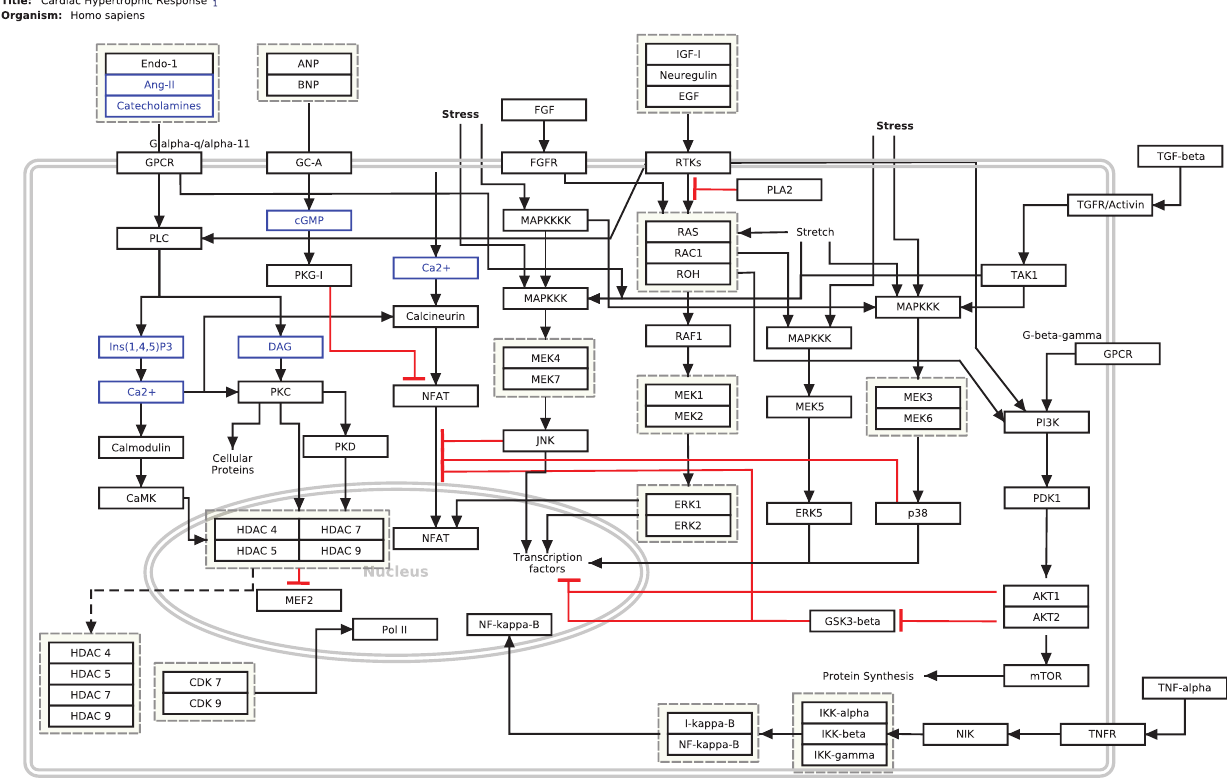
Supplementary Figure 1. Human Cardiac Hypertrophic Response pathway from WikiPathways used in the manuscript: http://